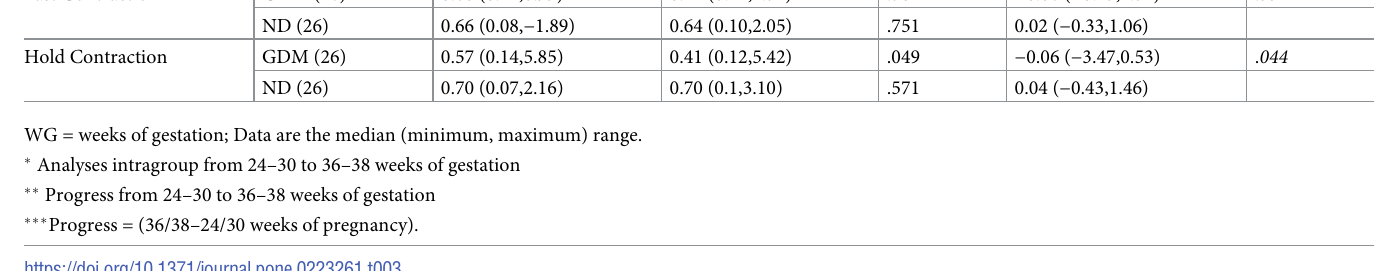
Table 3. Progress and analysis intragroup of normalized Root Mean Square (RMS) Values From Electromyography Activity of Pelvic Floor Muscles (PFM) in Rest, Fast Contraction and Hold Contraction of the non-diabetic (ND) and Gestational Diabetes Mellitus (GDM) at 24–30 and 36–38 weeks of gestation.